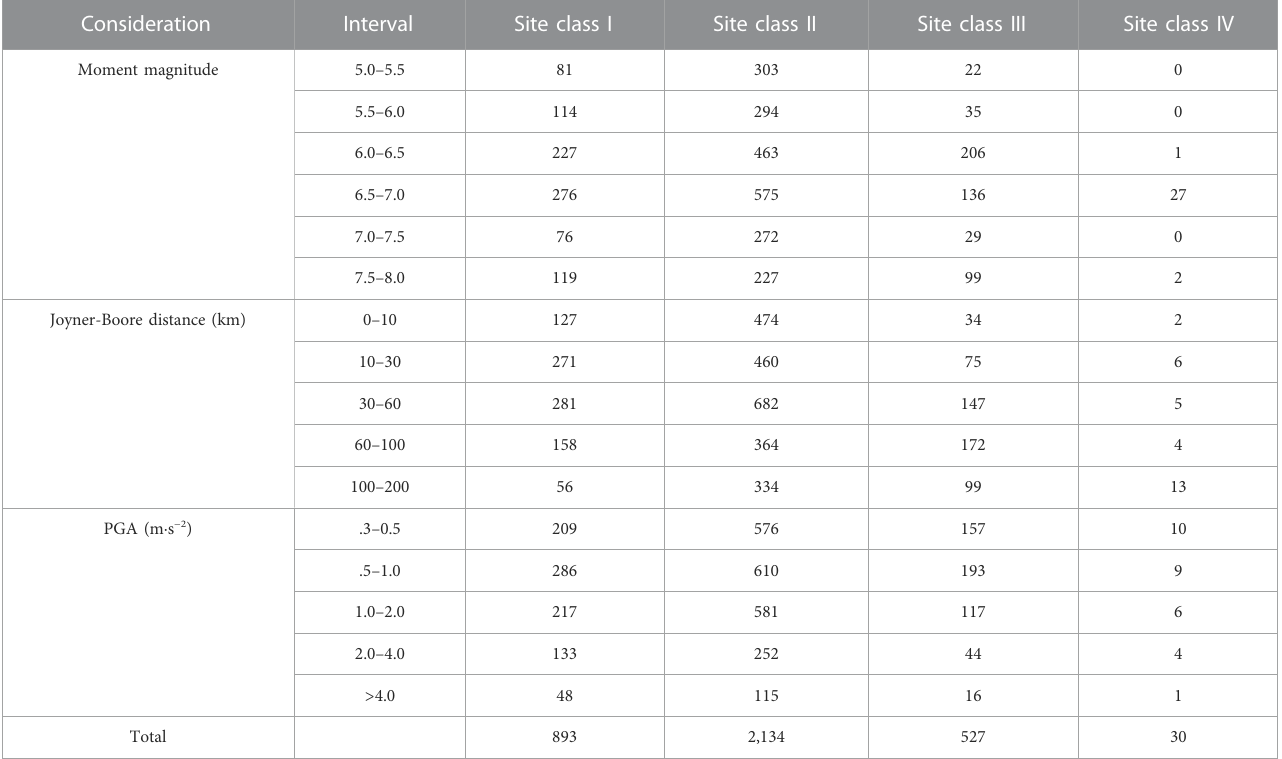
TABLE 4 Sample capacities of records from NGA-West2 database on each site